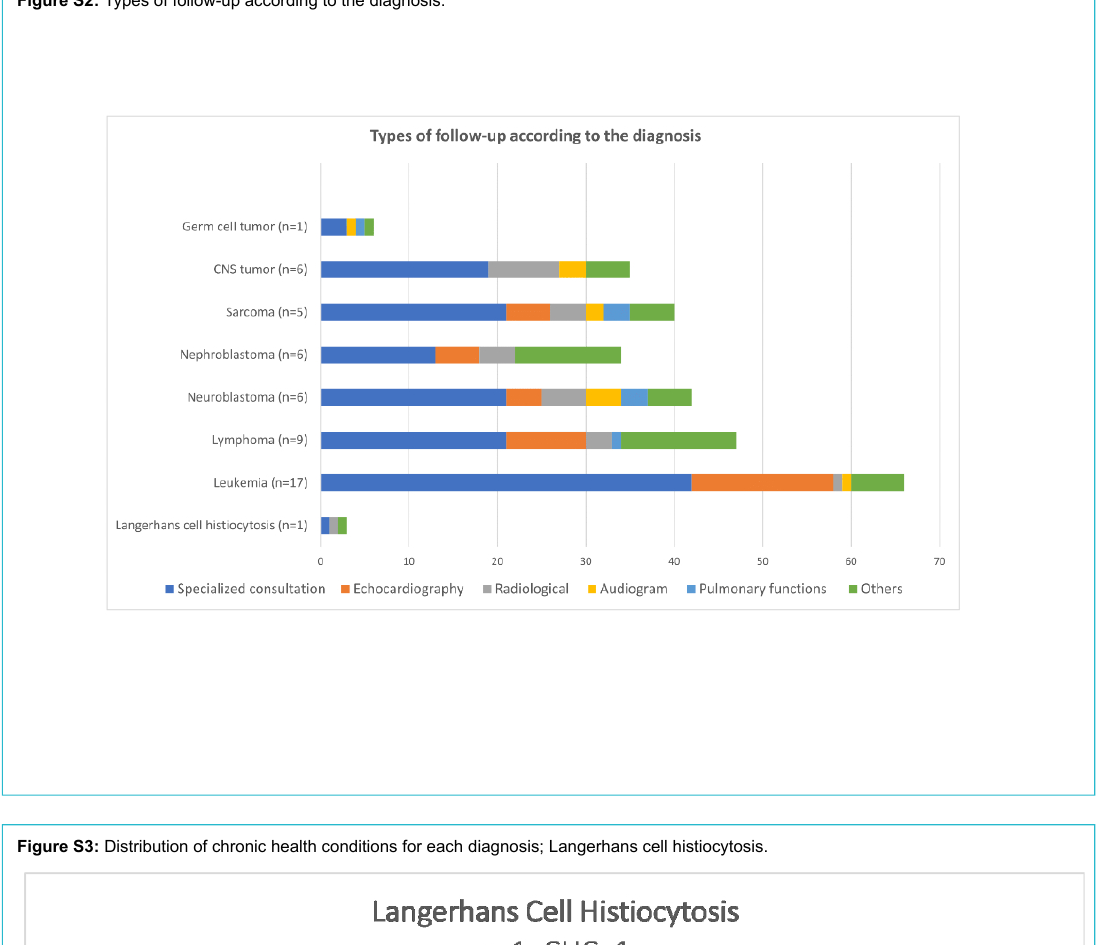
Figure S2: Types of follow-up according to the diagnosis.